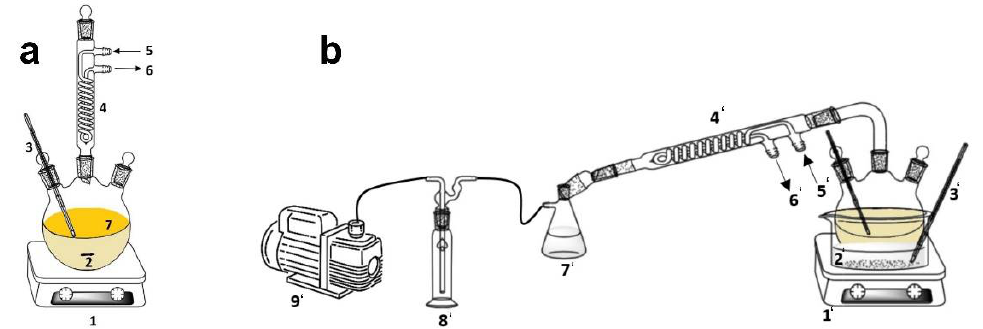
Figure 18. Experimental arrangement for ( a ) biodiesel production (1, heating system; 2, reactor; 3, temperature probe; 4, condenser; 5 and 6, water inlet and outlet; 7, reaction medium); ( b ) biolubri- cant production (1′, heating system; 2′, heating bath; 3′, temperature probe; 4′, condenser; 5′ and 6′, water inlet and outlet; 7′, methanol trap; 8′, trap flask; and9′, vacuum pump).